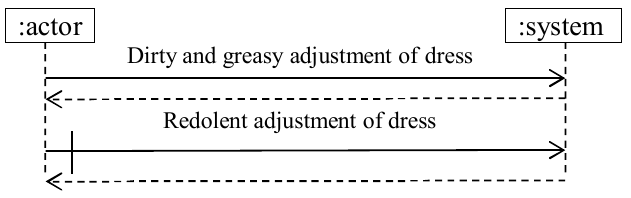
Fig. 2. Fuzzy sequence diagram for washing